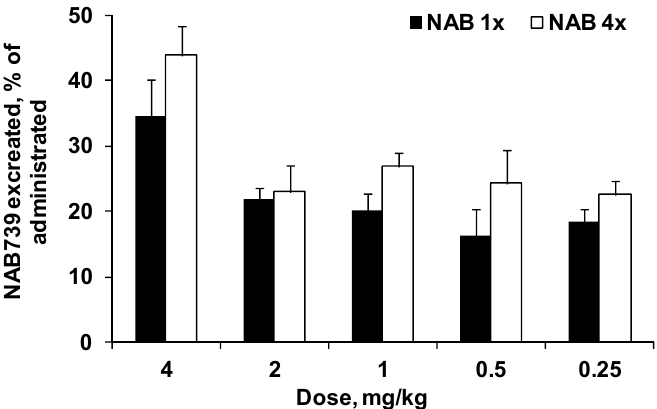
Figure 5. Relative amounts of compound eliminated by urine after the first and the last SC Figure5. RelativeamountsofcompoundeliminatedbyurineafterthefirstandthelastSCadministration administration of NAB739 at doses of 0.25–4 mg/kg. Relative amounts expressed as a percentage of of NAB739 at doses of 0.25–4 mg / kg. Relative amounts expressed as a percentage of the amount of the amount of compound administrated in mice at particular dose. Data expressed as average ±SEM compound administrated in mice at particular dose. Data expressed as average ± SEM from four from four NMRI mice. NMRI